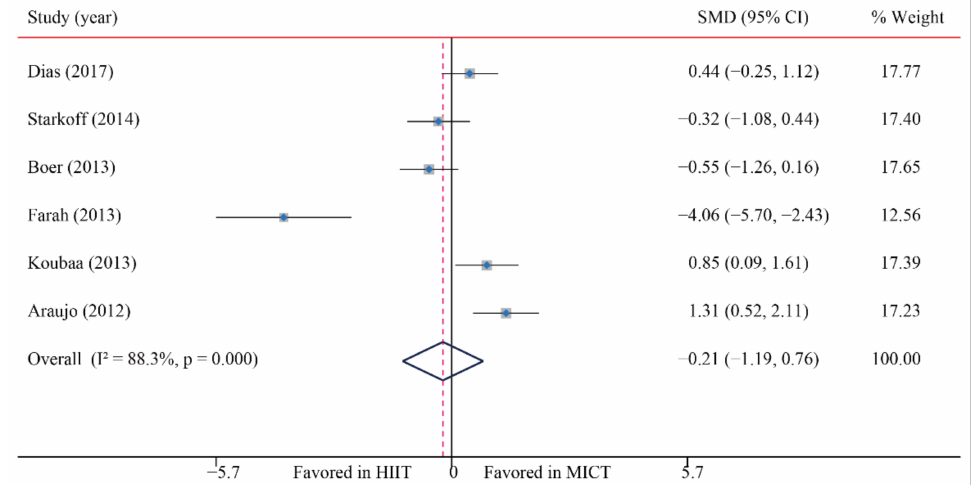
Figure 6. Effect of HIIT versus MICT on abdominal fat.